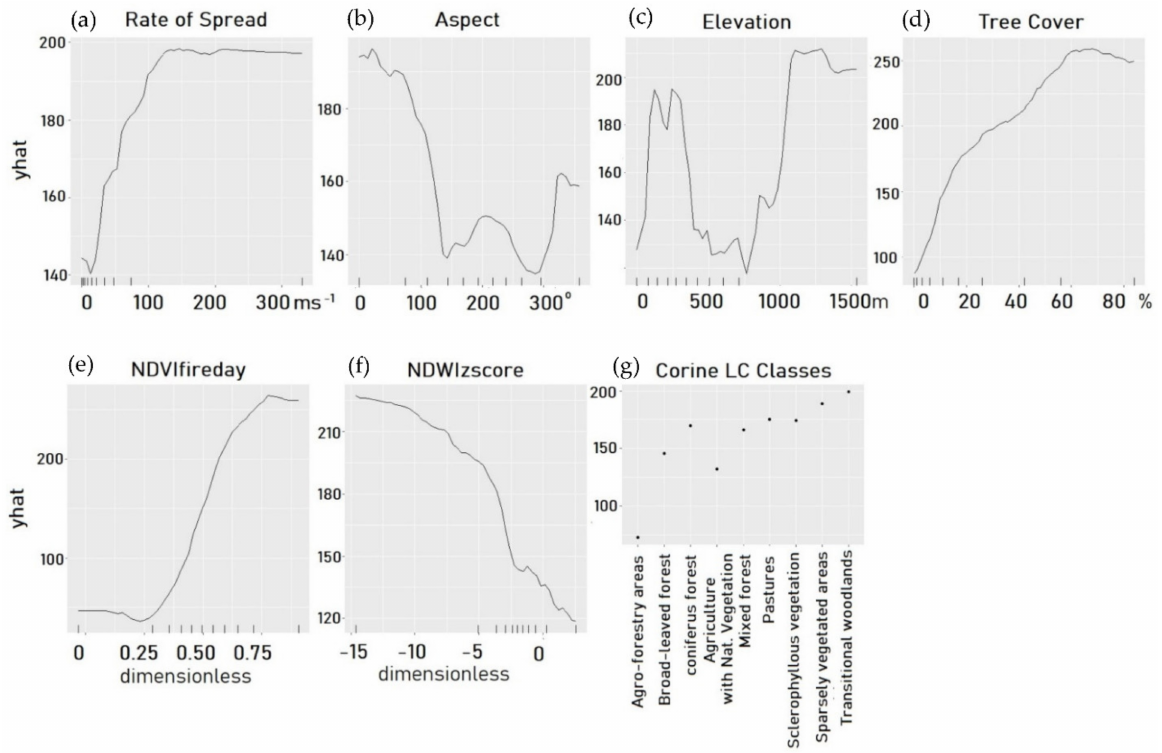
Figure 7. Partial dependence plots showing the marginal effect (yhat) of each explanatory variable ( a – g ) on rdNBR. Vertical black marks represent deciles values of each explanatory variable. As an example, for operational purposes, the model was projected over the island of Sardinia for the 19 August 2019 (Figure 8). The map shows higher potential fire severity along the eastern mountainous areas.